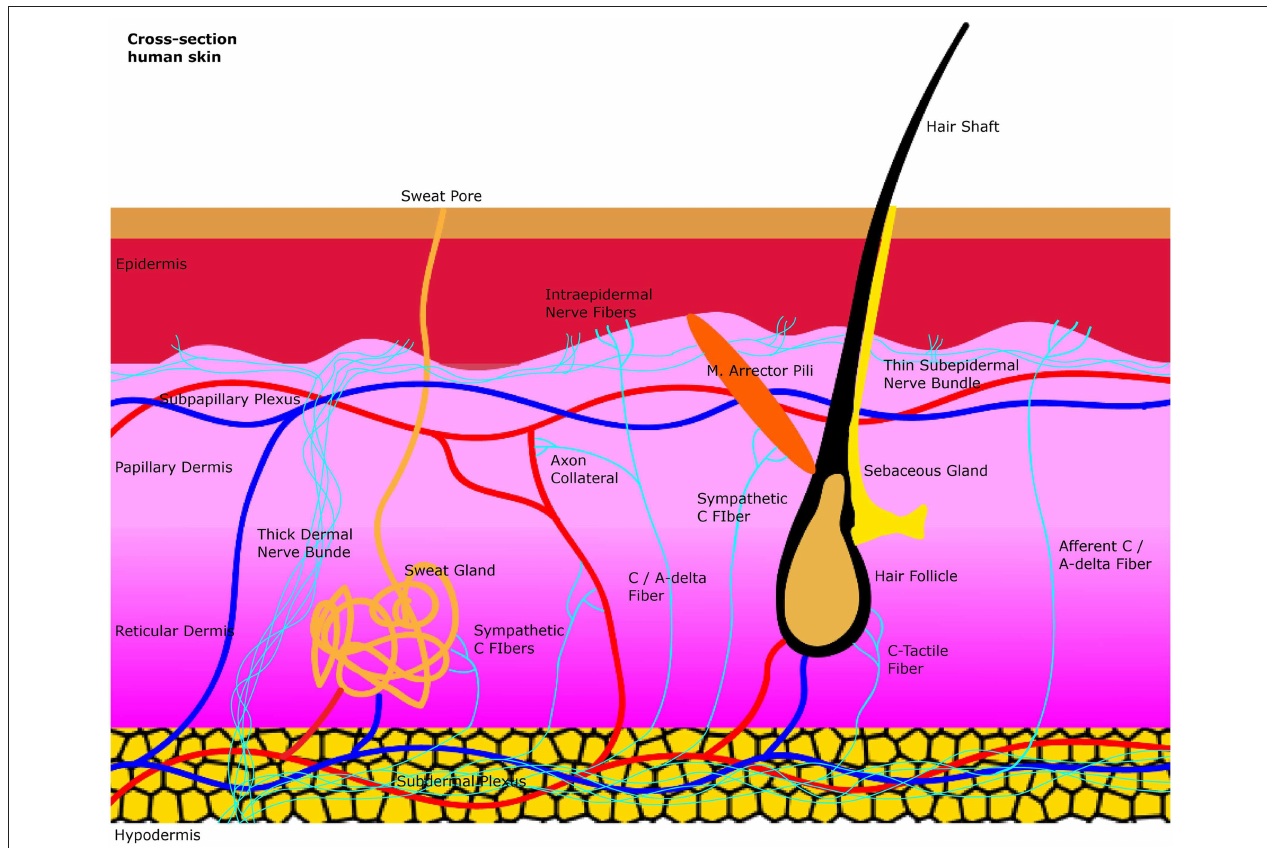
FIGURE 1 | A simplified illustration of the general anatomy of the skin with the focus on autonomic nerve fibers and their innervated organs. Sweat glands, blood vessels and the arrector pili muscle are innervated by sympathetic C-fibers in the dermis. Afferent intraepidermal nerve fibers of the class C and A δ are found in the epidermis as free nerve endings. Axon collaterals of these afferent fibers also supply blood vessels with efferent antidromic control. Small sensory fibers branch off from thicker dermal nerve bundles to create thinner subepidermal nerve bundles that innervate the